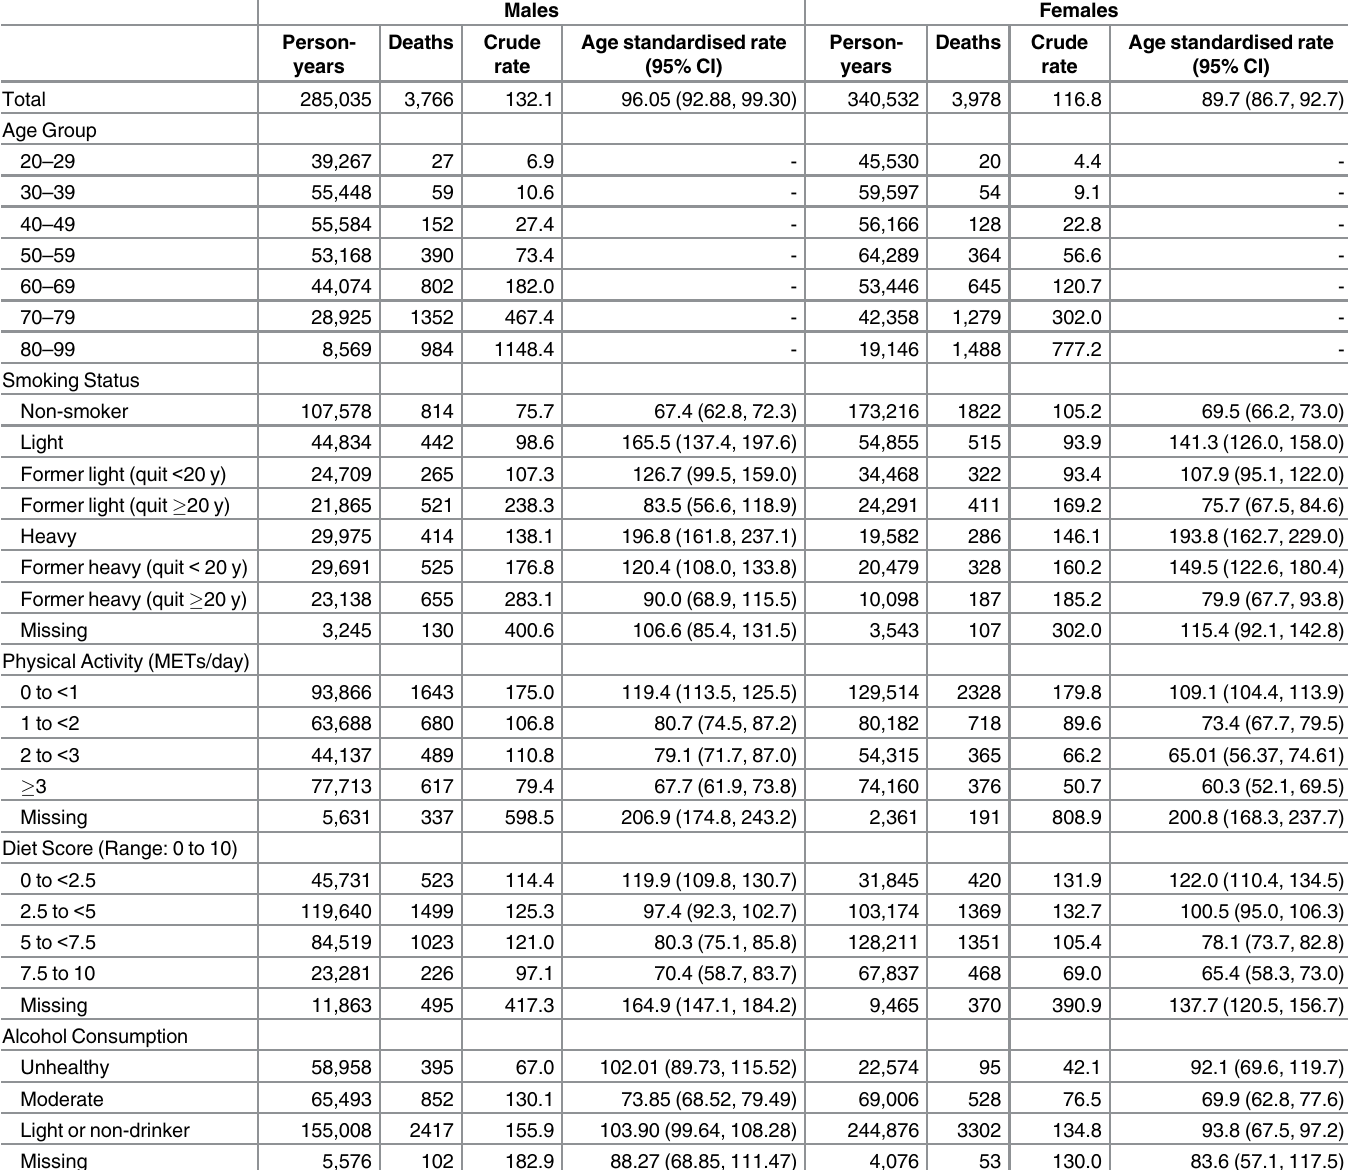
Table 4. Crude and age-standardized death rates per 10,000 person-years for health behaviour